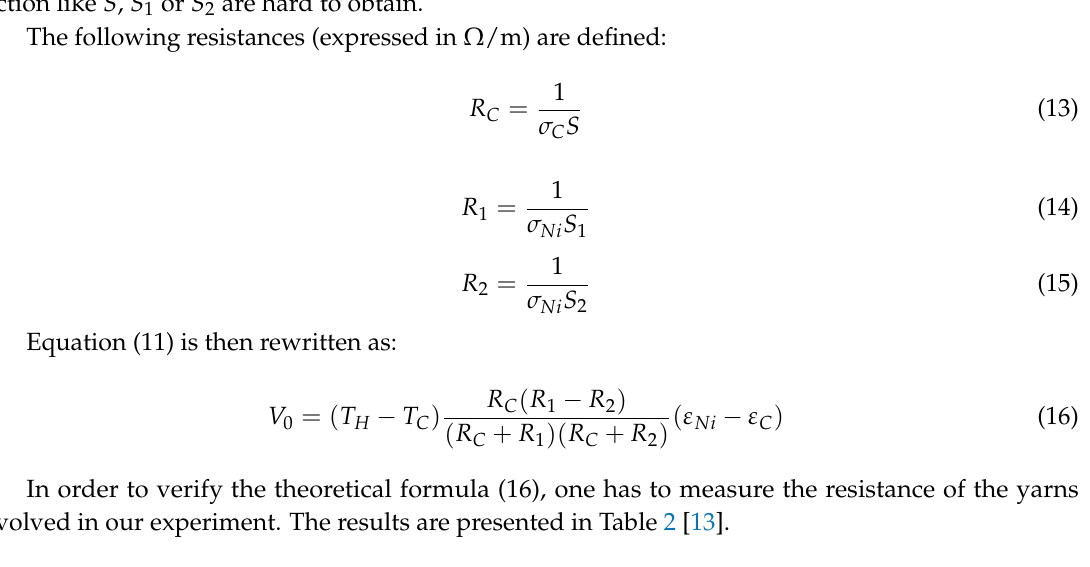
Table 2. Linear electrical resistance of etched and non-etched yarns [13]